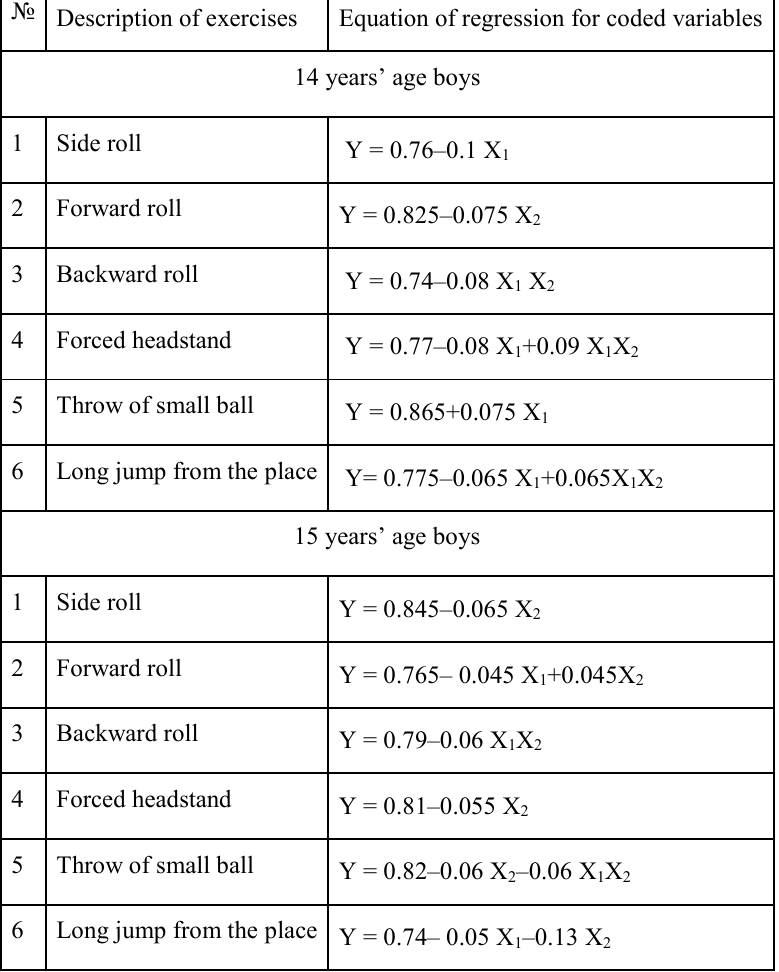
Регресійна залежність результатів в процесі навчання фізичним вправам хлопців 14–15 років від